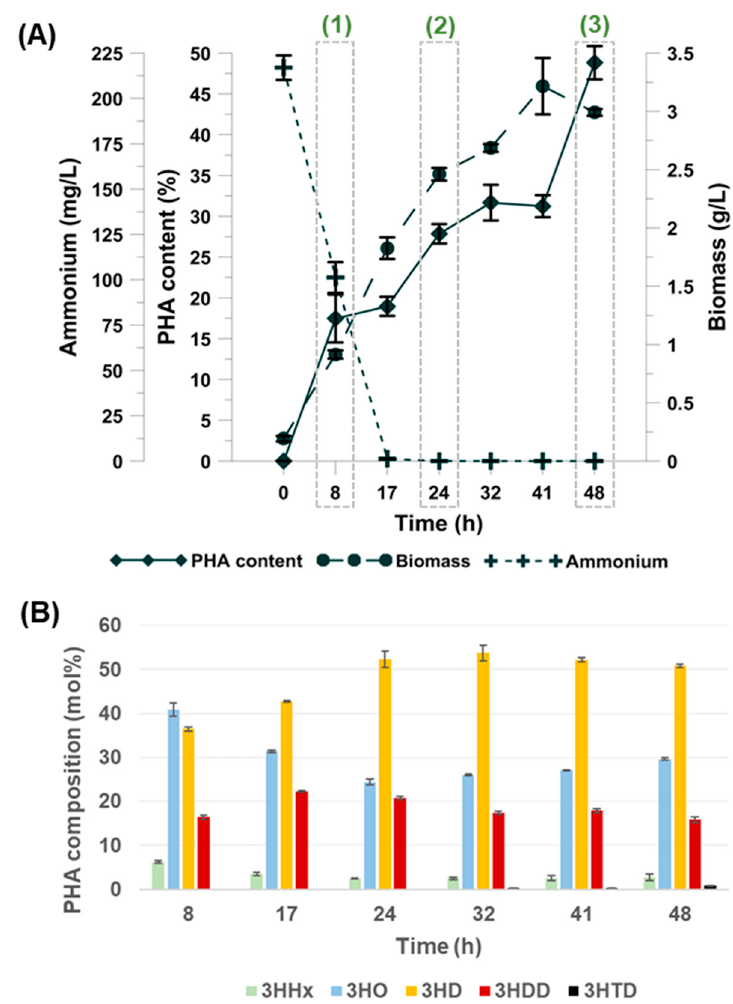
Figure 1. ( A ) Medium-chain-length polyhydroxyalkanoates (mcl-PHAs) content, biomass, and ammonium concentration during fed-batch fermentations of Pseudomonas putida KT2440. (1), (2), and (3) indicate bacterial samples collected for proteomic analysis at 8 h, 24 h, and 48 h of the cultivation, respectively. ( B ) Monomeric composition of mcl-PHAs produced by Pseudomonas putida KT2440 in bioreactor experiments. Mean values are calculated from triplicate measurements. 3HHx, 3-hydroxyhexanoic acid; 3HO, 3-hydroxyoctanoic acid; 3HD, 3-hydroxydecanoic acid;